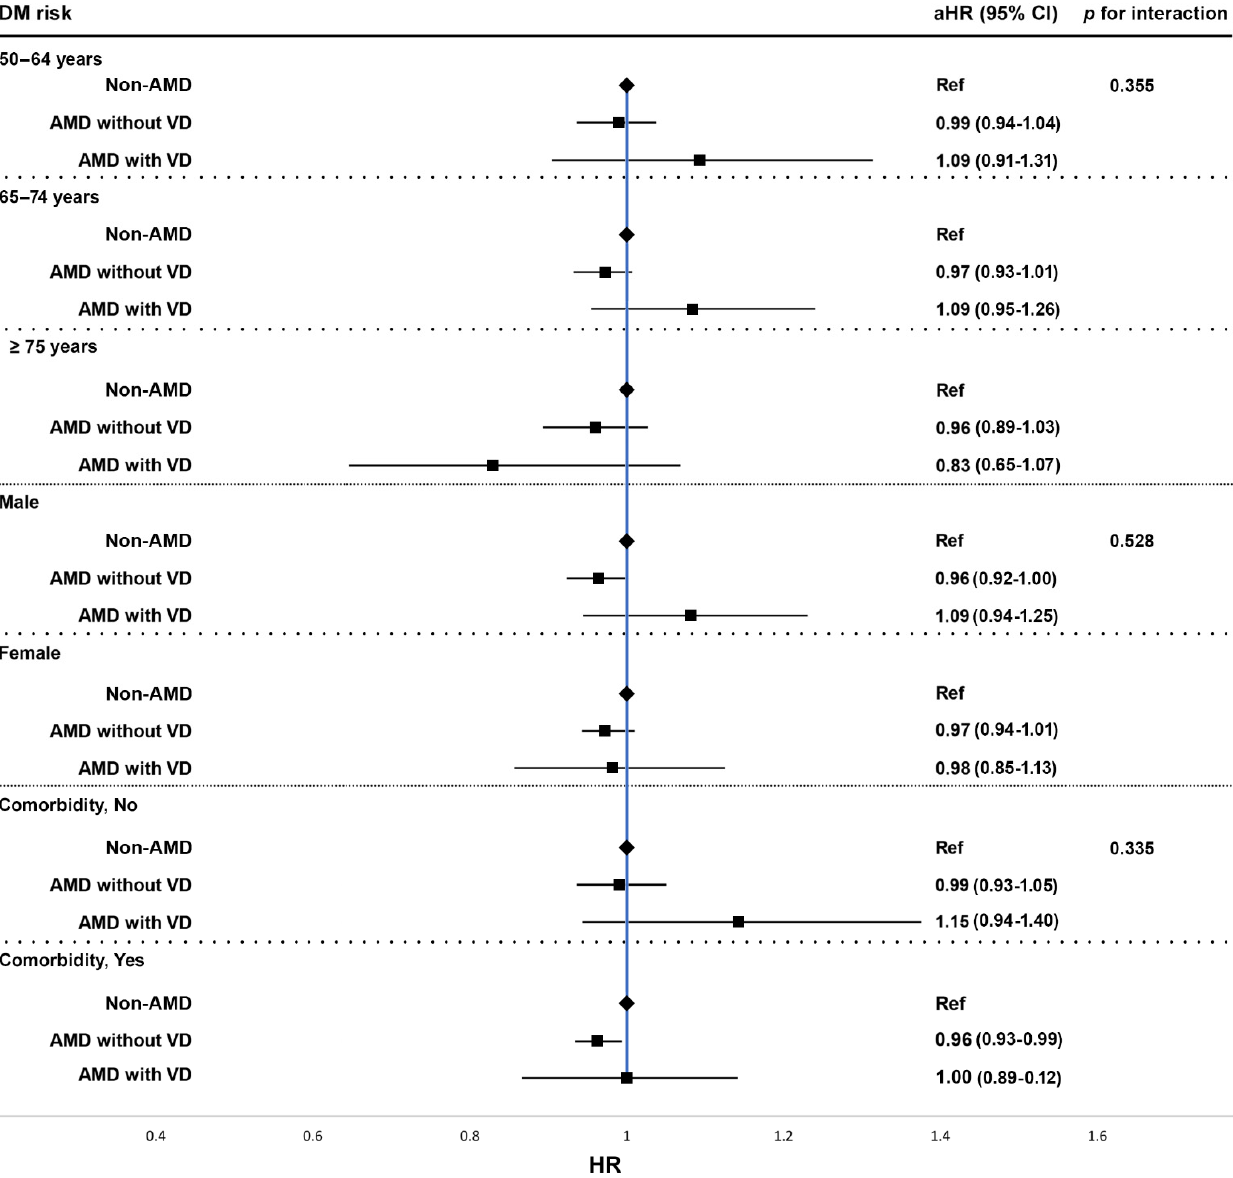
Figure 1. Forest plot of analyses stratified by age, sex, and comorbidity. HRs were adjusted for age, sex, income, area of residence, BMI, smoking, alcohol consumption, regular exercise, hypertension, dyslipidemia, CCI, fasting glucose level, serum hemoglobin level, and eGFR. Non-AMD group was reference (Ref). BMI, body mass index; CCI, Charlson Comorbidity Index; eGFR, estimated glomerular filtration rate; HR, hazard ratio; CI, confidence interval.